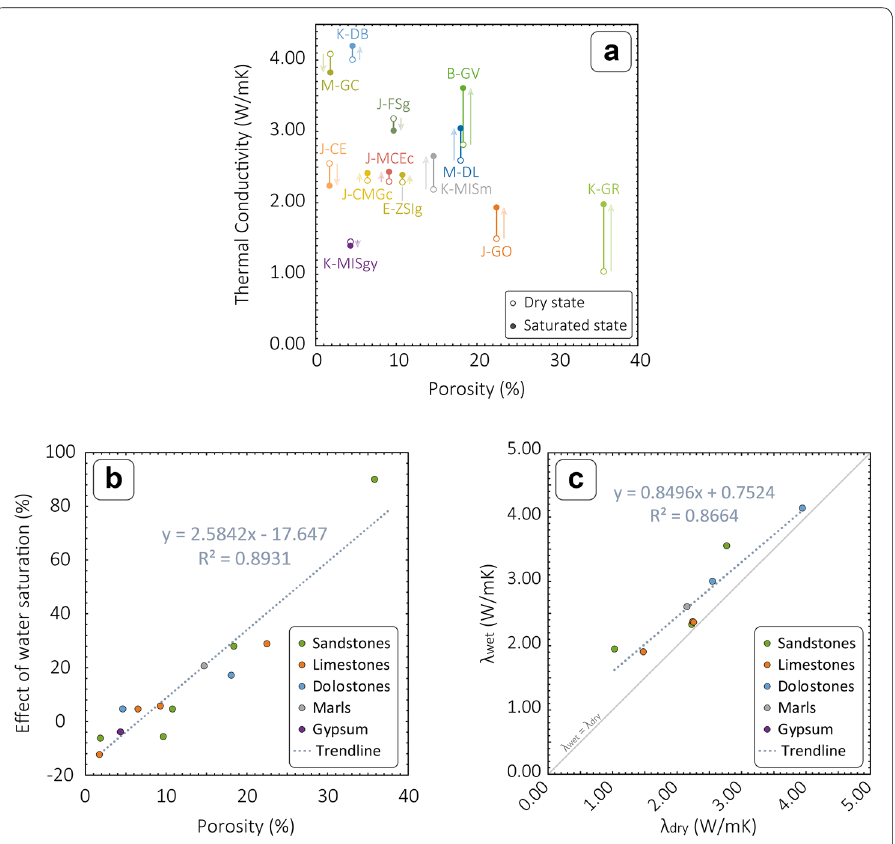
Fig. 7 a Thermal conductivity of the samples in the dry state at ambient temperature (empty circles) and in the saturated state at ambient temperature (filled circles) as a function of porosity. Lines join the dry and saturated conductivity values for the same sample and arrows indicate the direction of variation from dry to saturated. Colors indicate the lithology. b Effect of water saturation on thermal conductivity as a function of porosity of individual samples. Trendline and corresponding equation and coefficient of determination, R 2 , are given. c Comparison of thermal conductivities measured under dry state ( λ dry ) and water-saturated state ( λ wet ). Trendline and corresponding equation and coefficient of determination, R 2 , are given. The equation of the trendline is used for wet thermal conductivity estimates for samples measured only in the dry